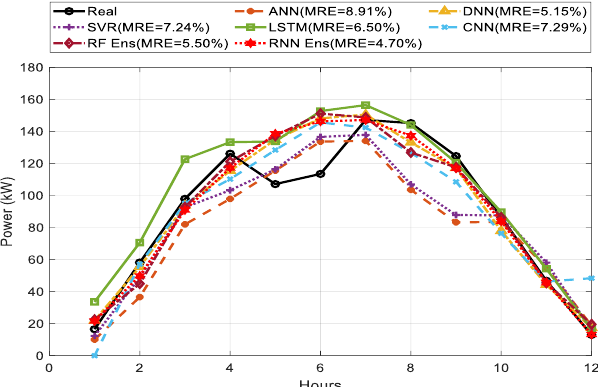
Figure 10. One-day ahead PV power forecasting results for sunny days between single model and ensemble model.